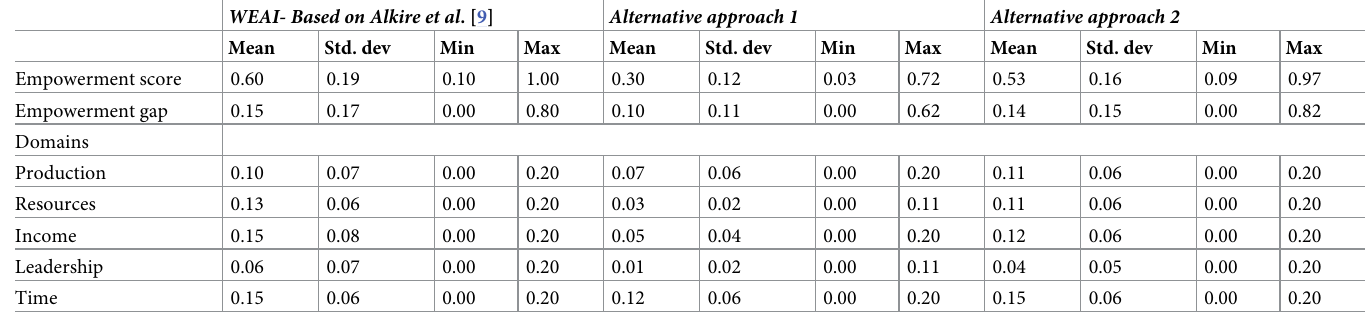
Table 3. Summary statistics of WEAI and alternative empowerment measures. WEAI- Based on Alkire et al .